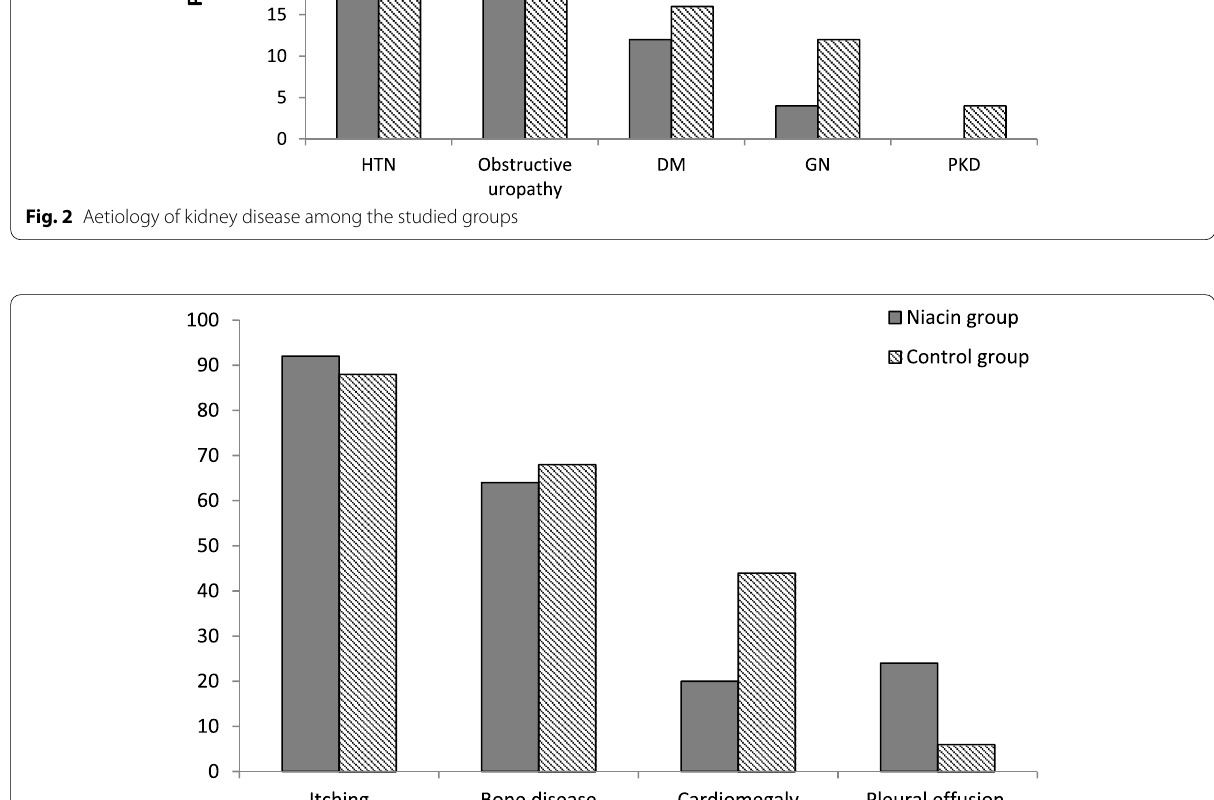
Fig. 3 Itching, bone disease and radiological findings among the studied